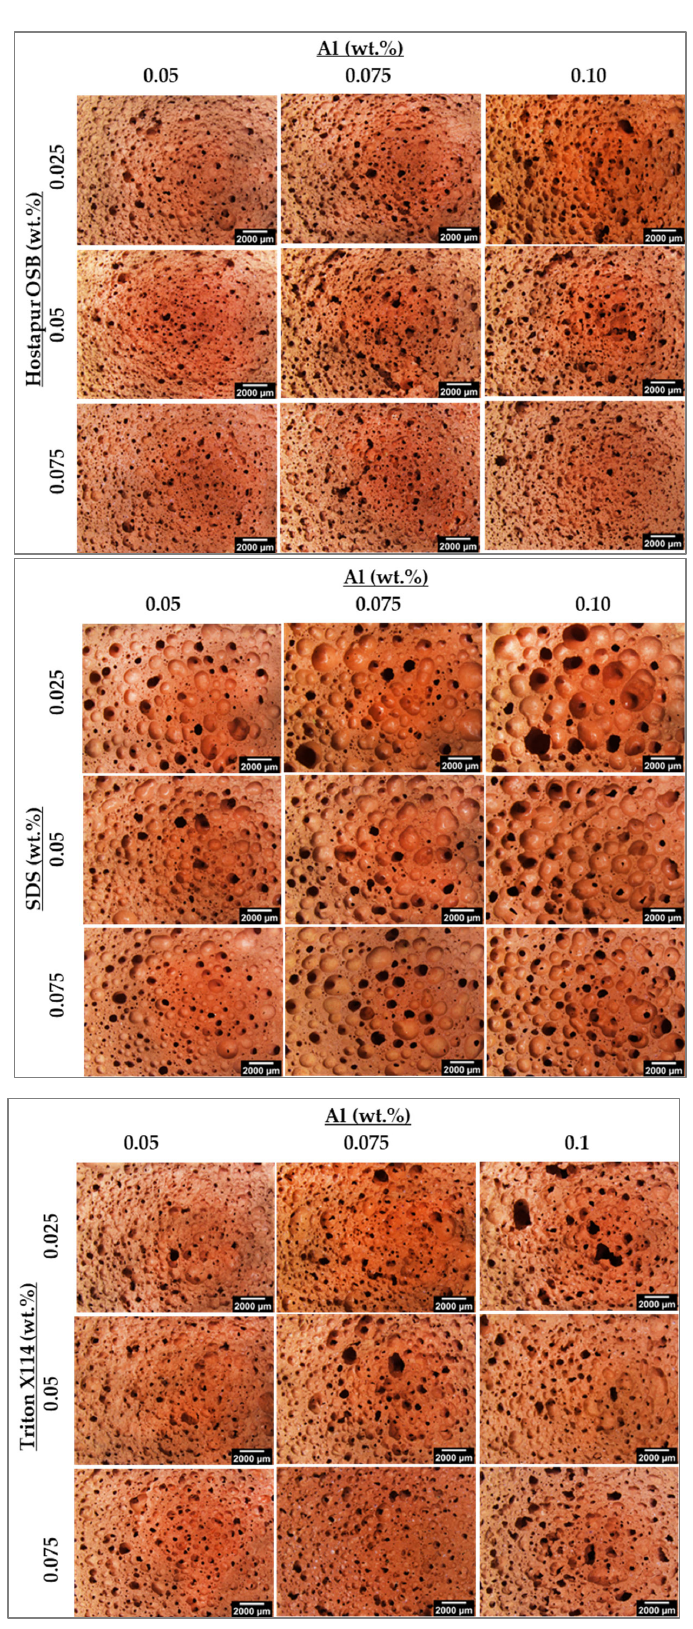
Figure 4. Optical microscope photographs of samples produced using various surfactants.